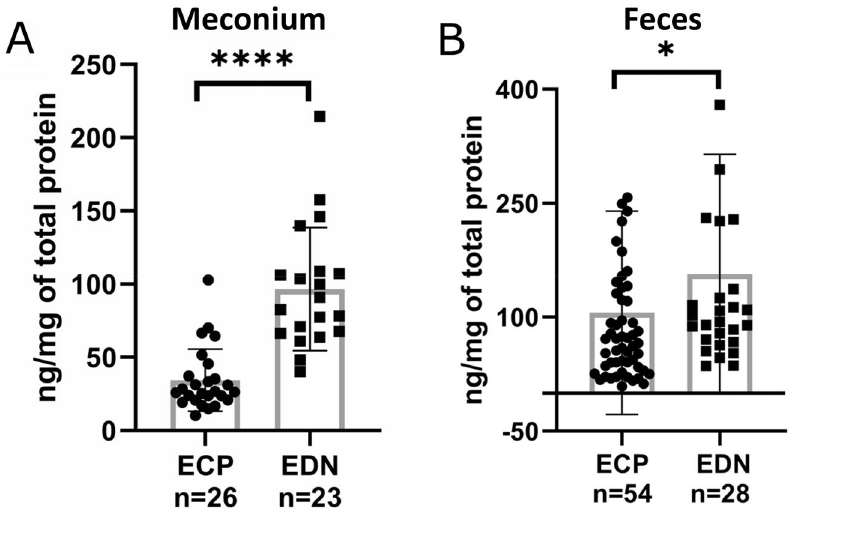
Figure 3. ECP and EDN levels in meconium and feces. ( A ) meconium (n = 41) and ( B ) feces (n = 70), Mann– Whitney U test, * P < 0.05, **** P < 0.0001.